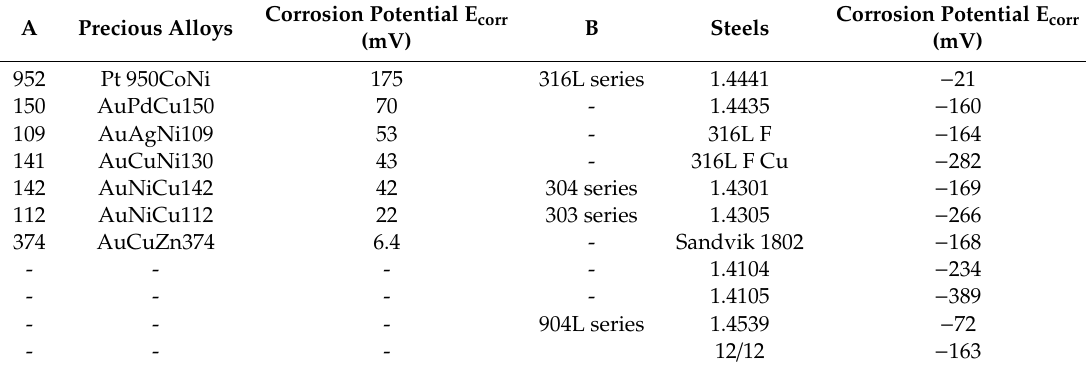
Table 11. Galvanic series established in an EN1811-2011 + A1:2015 artificial sweat type environment.